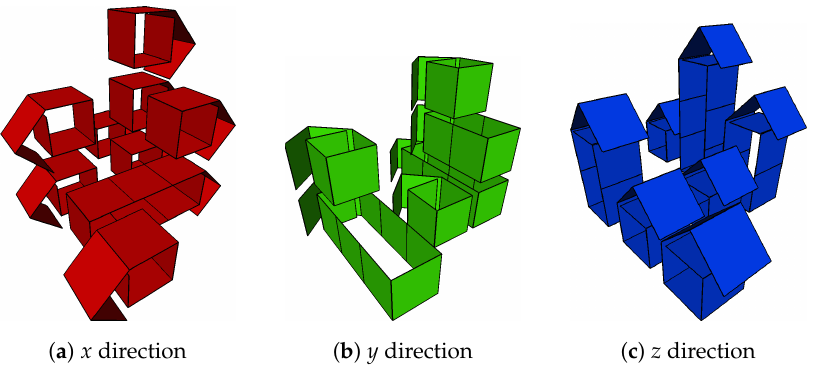
Figure 6. All modules in the three spatial directions.